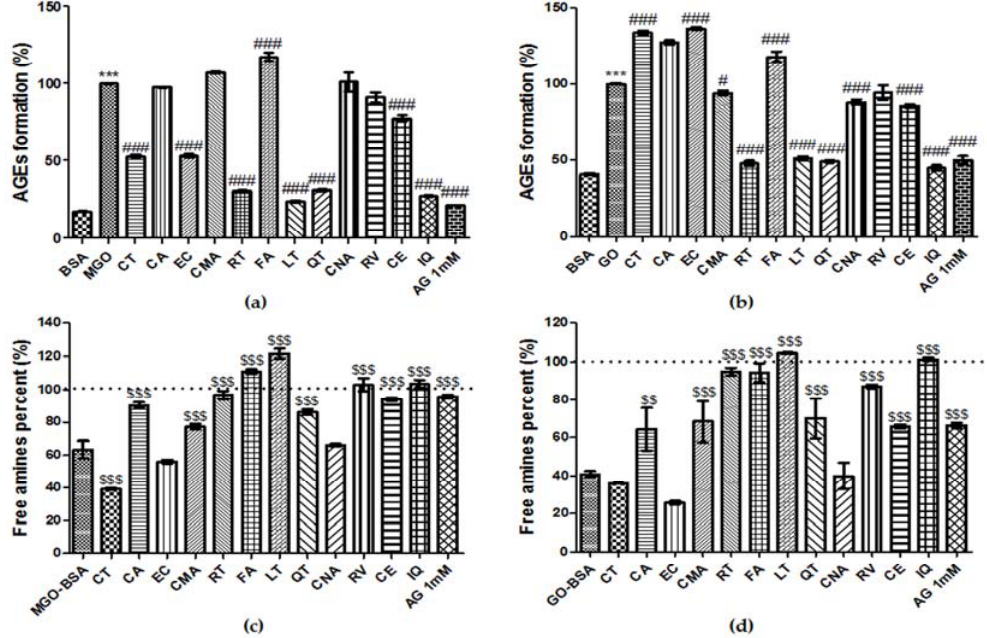
Figure 4. The effects of phenolic compounds on methylglyoxal (MGO)-induced glucotoxicity. The effects of phenolic compounds on in vitro advanced glycation end product (AGE) formation were examined using an AGE formation assay: MGO-mediated AGE formation ( a ); and glyoxal (GO)-mediated AGE formation ( b ). Bovine serum albumin (BSA; mg/mL) was incubated with 2 mM MGO or GO in the presence or absence of each sample (400 µ M) in phosphate-buffered saline for 7 days. The AGE-breaking ability of phenolic compounds was evaluated by breaking of: MGO-BSA ( c ); and GO-BSA ( d ), using the TNBS assay. The baseline frequency of BSA free amines is represented by the dotted line at 100%. The percentage values of each experiment are presented as the mean ± SD of three independent experiments. (*** p < 0.001 vs. control; # p < 0.05 and ### p < 0.001 vs. MGO or GO treatment only; $$ p < 0.01 and $$$ p < 0.001 vs. MGO- or